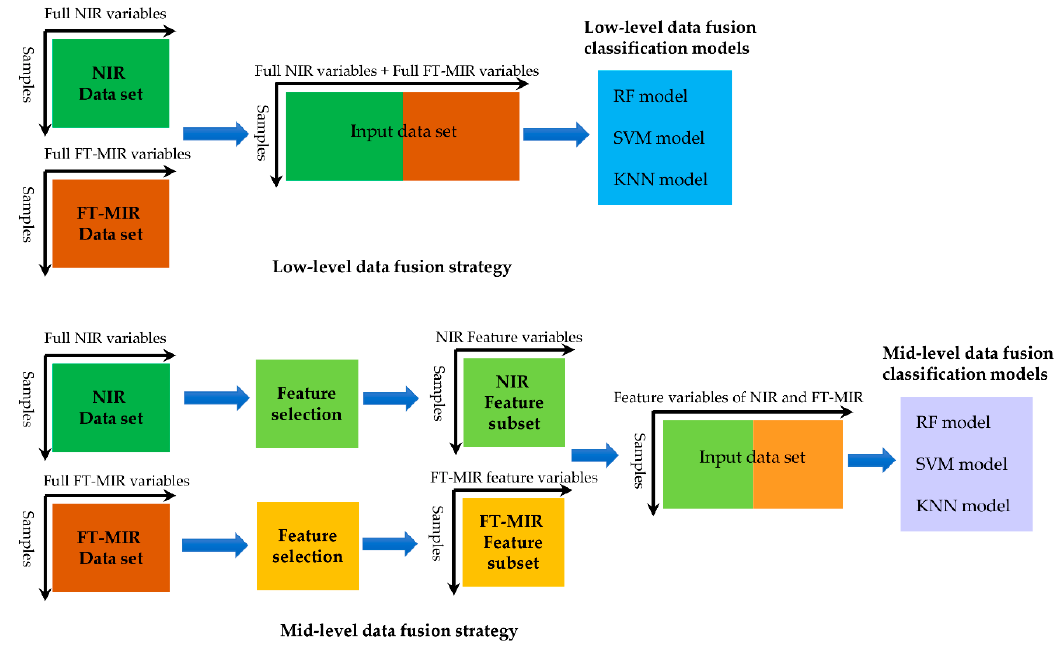
Figure 10. The low-level and mid-level data fusion strategies in the study. Table 10. The major parameters (accuracy and kappa) of the data fusion models.